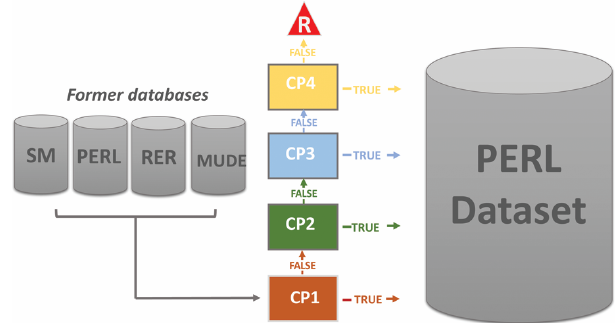
Figure 2. Synthetic workflow of the method used to merge the MUDE, RER, and SM databases, as well as the new realization in- vestigations, into the PERL